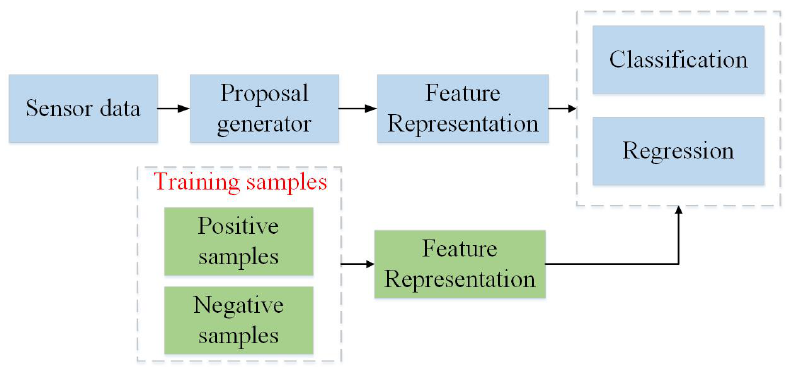
Figure 3. A general framework of object detection. Table 1. Comparison of 3D object detection methods with different